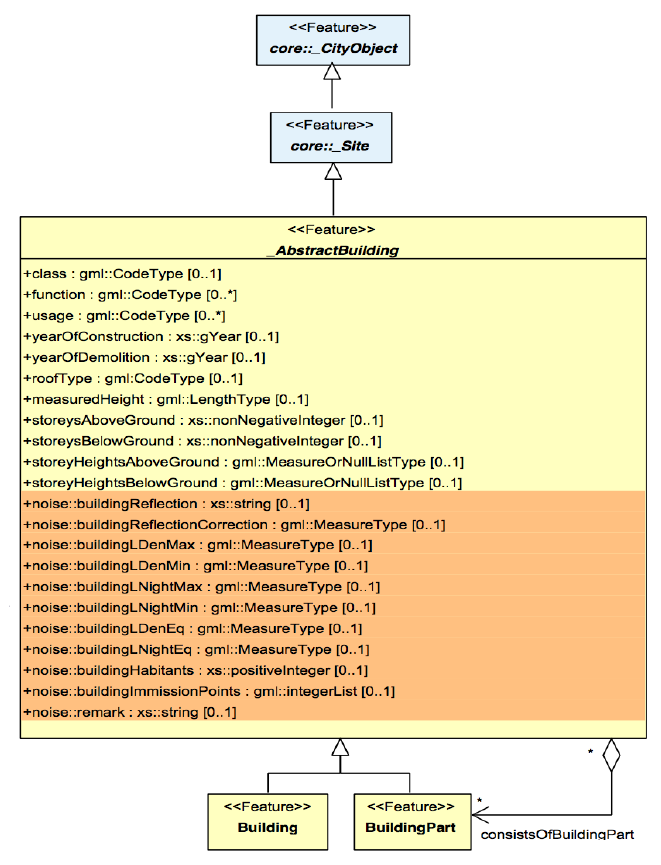
Figure 5: CityGML Noise ADE UML for buildings (light yel- low=CityGML Transportation module, light orange=CityGML Noise ADE) (Groger et al.,